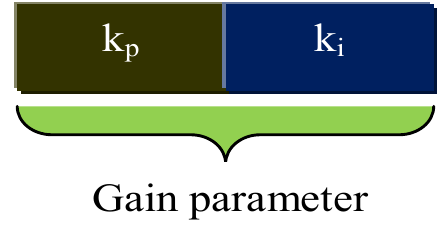
Figure 4. Solution encoding of proposed algorithm.